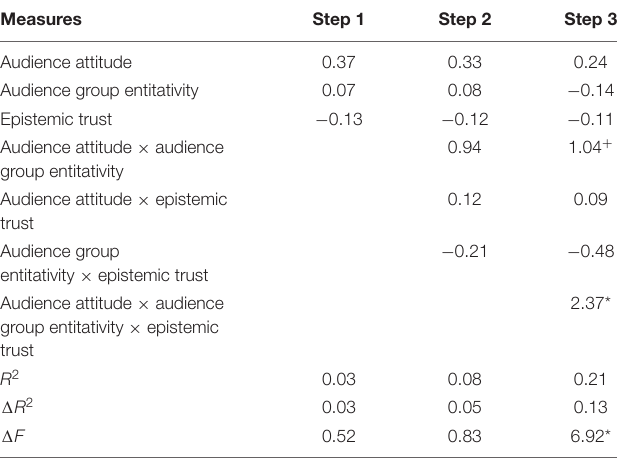
TABLE 3 | Moderated multiple regression analysis with impression valence as a function of audience attitude, audience group entitativity, and epistemic trust (non-standardized regression coefficient).